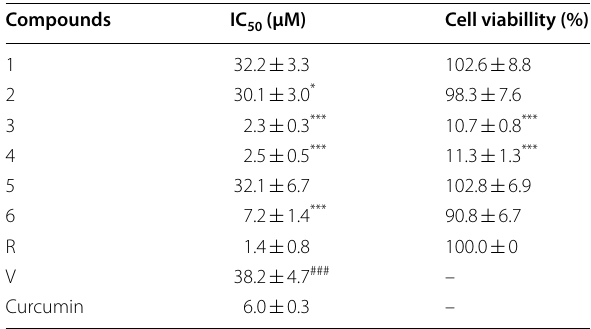
Data are as the mean * p < 0.05, ** p < 0.01, and *** p < 0.001 compared with the stimulation